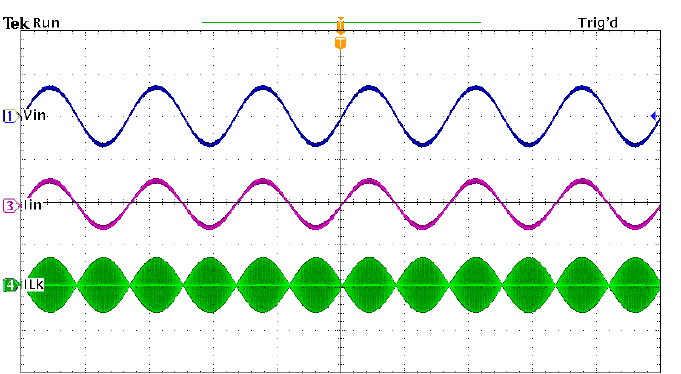
Figure 9. Low-frequency signals of the AC–DC DAB converter. From top to bottom, input voltage (250 V/div), input current (5 A/div), and DAB series inductance current (25 A/div).